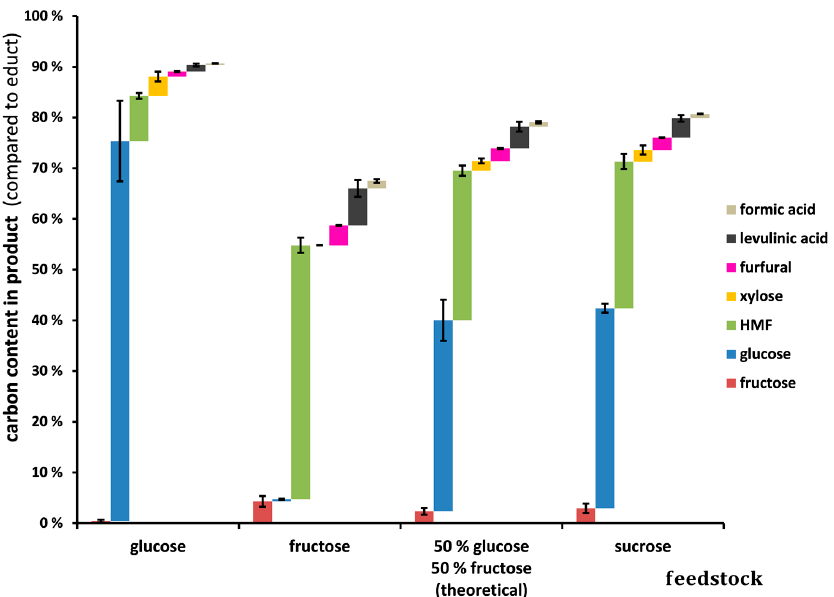
Figure 5. Carbon composition after acid-catalyzed conversion of glucose, fructose, and sucrose at a residence time of 10 min and temperature of 220 °C. The column “50% glucose 50% fructose (theoretical)” shows a calculated 1:1 mixture of glucose and fructose. Feedstock contained 0.005 mol/L sulfuric acid and either 2 wt % sucrose, 1.05 wt % glucose, or 1.05 wt % fructose.